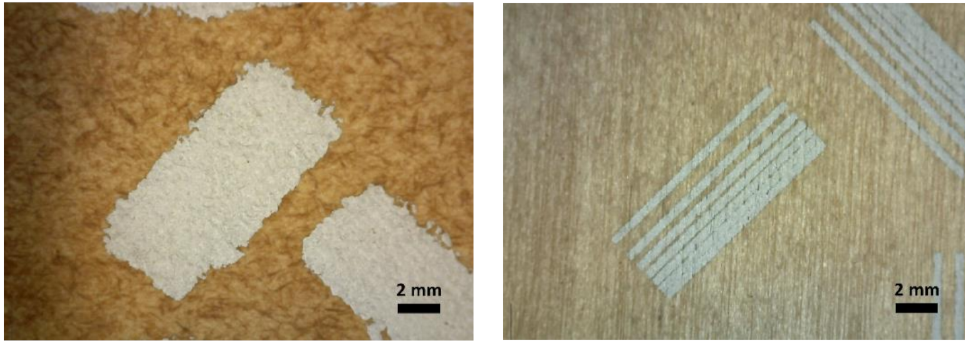
Figure 4. Minimum-gap-width test structure printed on CB_Z33 ( left ) and Veneer_Z33 ( right ) substrates.